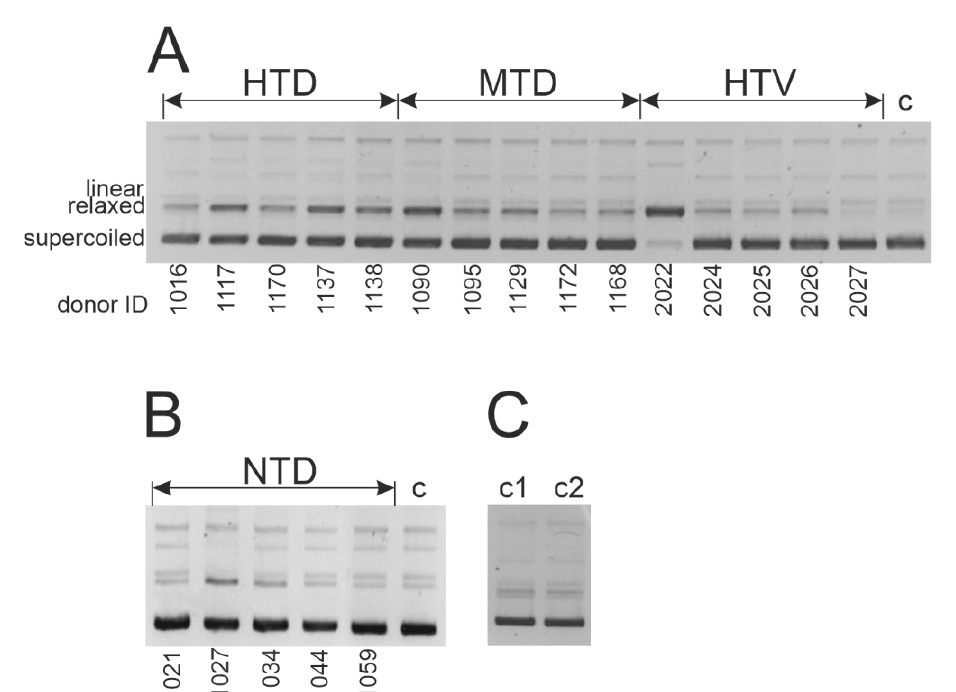
Figure 6. Analysis of the DNA-hydrolyzing activity of IgG preparations. To illustrate, the data for five samples of each group are provided: HTD, MTD, HTD ( A ), and NTD ( B ) in the cleavage of double-stranded supercoiled pBluescript plasmid DNA leading to the relaxed plasmid formation. ( C )—control samples (c, c1, c2) did not contain IgG samples and were incubated for 48 h (c), 72 h (c1), and 120 h (c2), respectively.